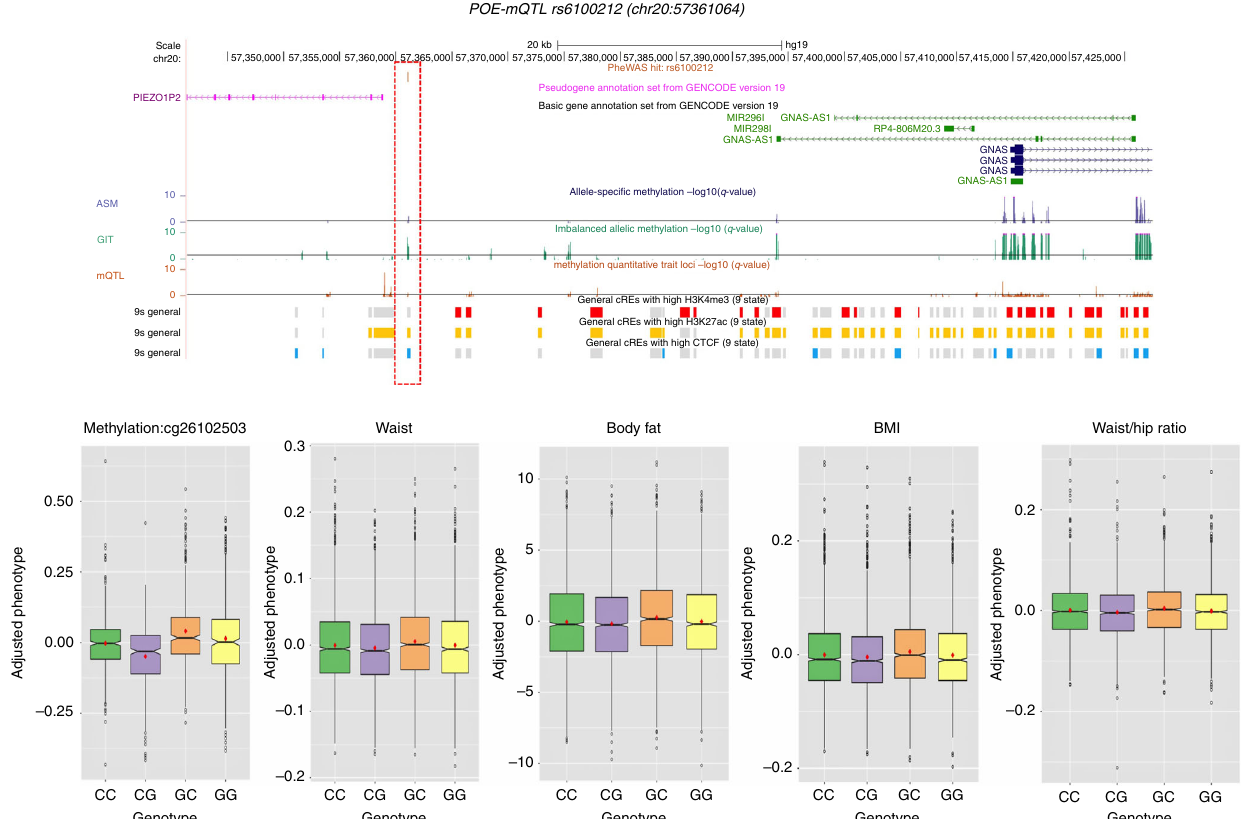
Fig. 5 CpGs and complex traits regulated by SNP rs6100212. Upper: this SNP was located upstream of gene PIEZO1P2 and overlapped with H3K27ac and CTCF signals. The SNP was also signi fi cant for imbalanced methylation (GIT), but not signi fi cant in allelic-speci fi c methylation (ASM) or mQTL (classical additive model) analysis as reported by an independent study. Left bottom: the SNP acted as a cis -POE – mQTL for methylation sites causing a complex imprinting pattern (cg26102503 as an example). Middle and right bottom: the SNP was also shown a regulatory role in waist (Phenome-wide signi fi cance), BMI, body fat and WHR (per-trait signi fi cance), introducing a similar complex imprinting pattern. Boxplots: centre line, median; box limits, upper and lower quartiles; whiskers, 1.5× interquartile range; points,